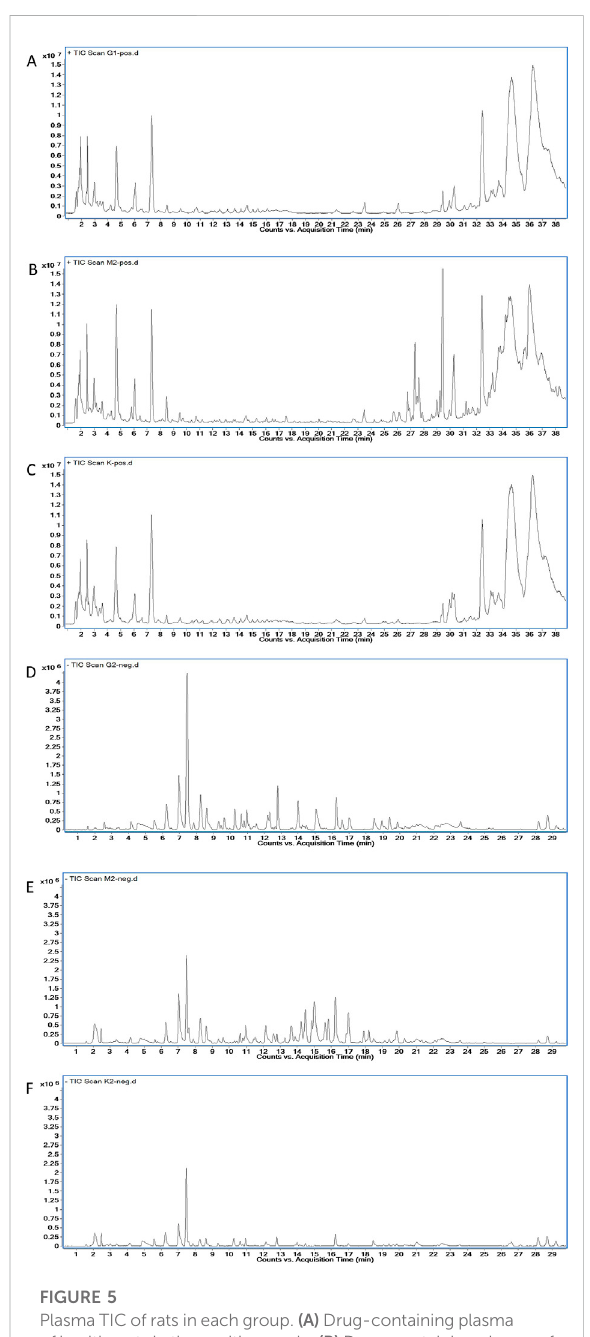
FIGURE 5 Plasma TIC ofrats ineach group. (A) Drug-containing plasma ofhealthyratsinthepositivemode. (B) Drug-containing plasmaof COPD rats in the positive mode. (C) Blank plasma of healthy rats in the positive mode. (D) Drug-containing plasma of healthy rats in the negative mode. (E) Drug-containing plasma of COPD rats in the negative mode. (F) Blank plasma of healthy rats in the negative